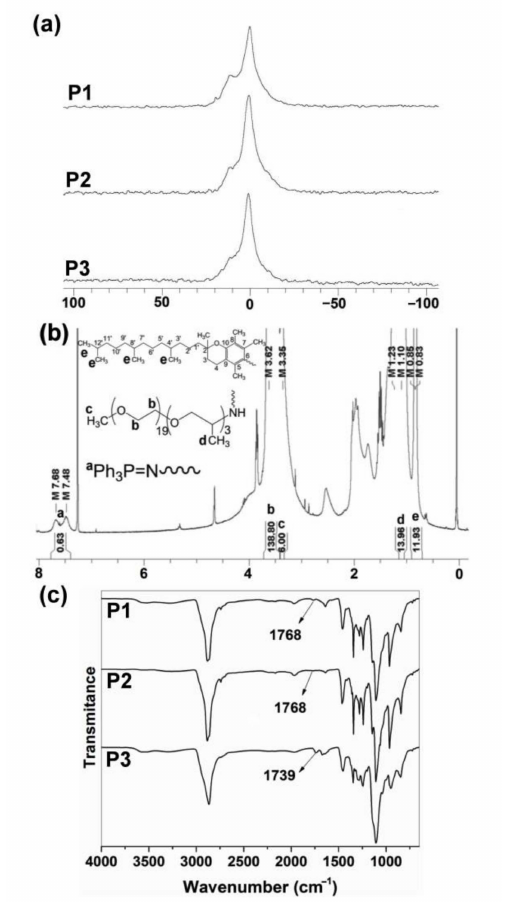
Figure 2. ( a ) 31 P{ 1 H} NMR spectra of P1–P3 polyphosphazenes in CDCl 3 . ( b ) 1 H NMR spectrum of P1 in CDCl 3 . DP was calculated as DP